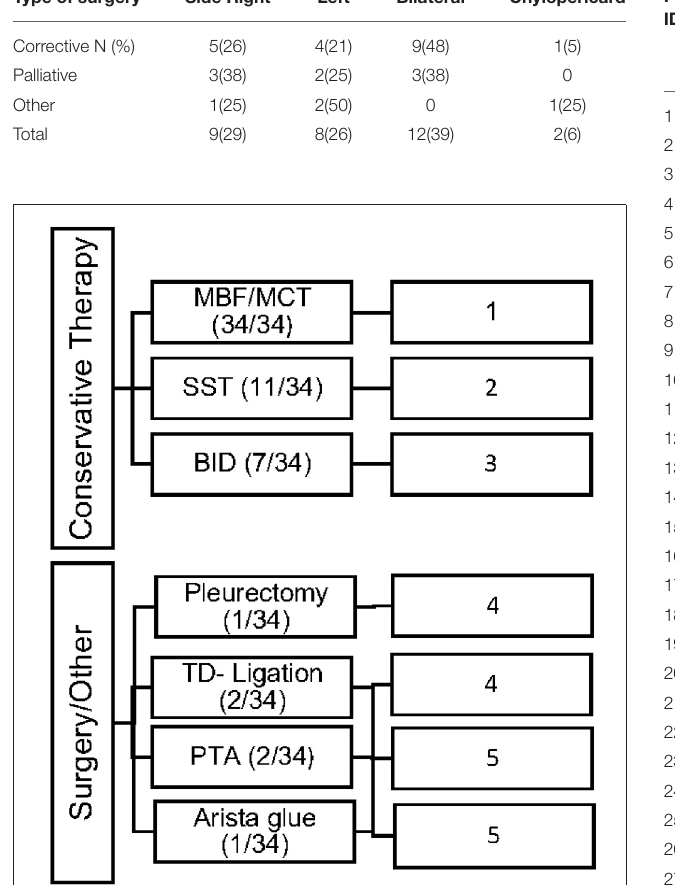
TABLE 2 | Correlation between type of surgery and chylothorax localization. Type of surgery